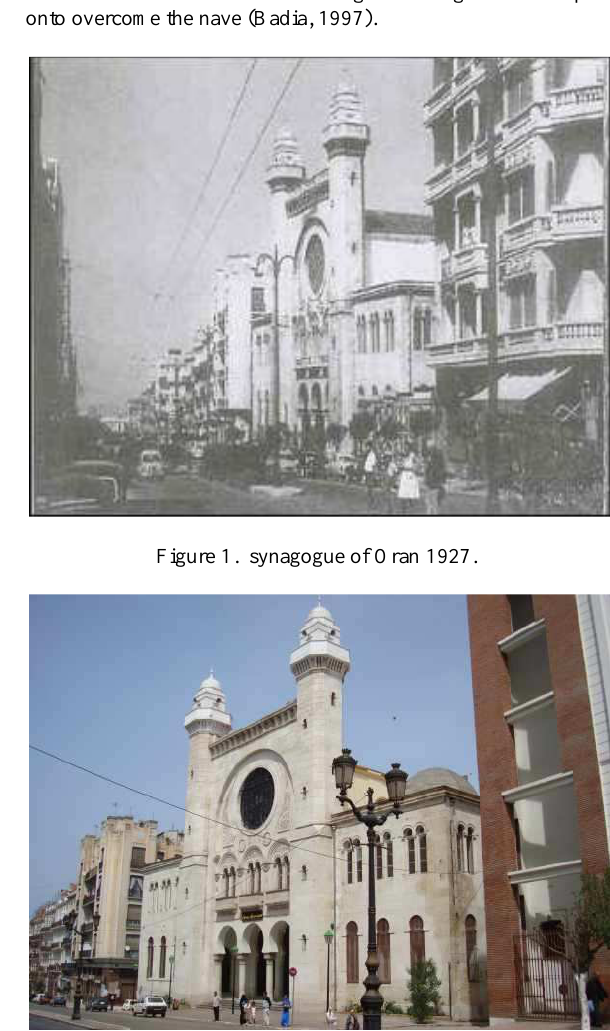
Figure 2. The mosque of Abdullah Ibn Salam 2010.